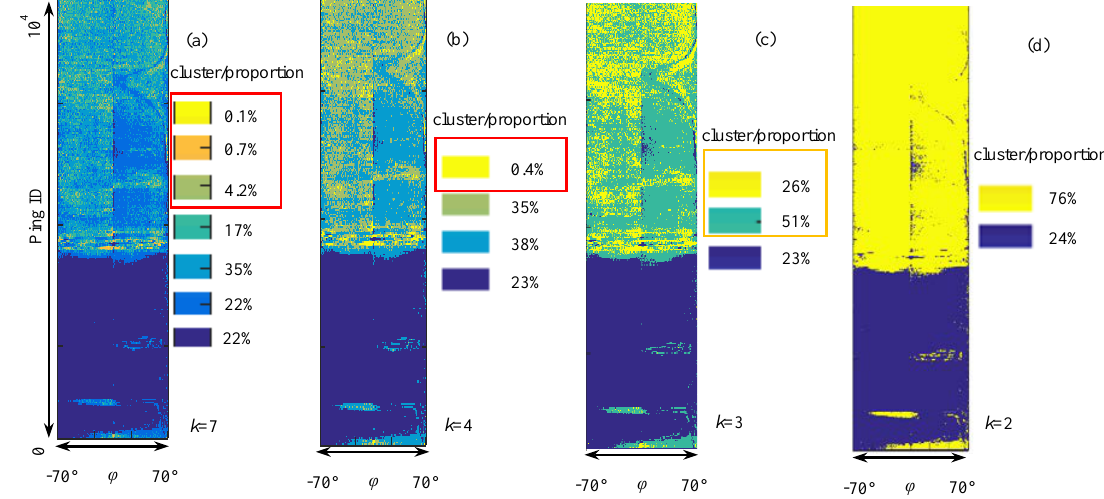
Figure 9. Iteration method for determining k and classification results under different given values of initial k ( k = 7 ( a ), 4 ( b ), 3 ( c ), and 2 ( d )). The red rectangle means that the proportion of these clusters is less than 5%, and the yellow rectangle denotes that the clusters’ center distance is extremely close (less than 5% of the BS variation range) and should be merged. φ denotes the incident angle